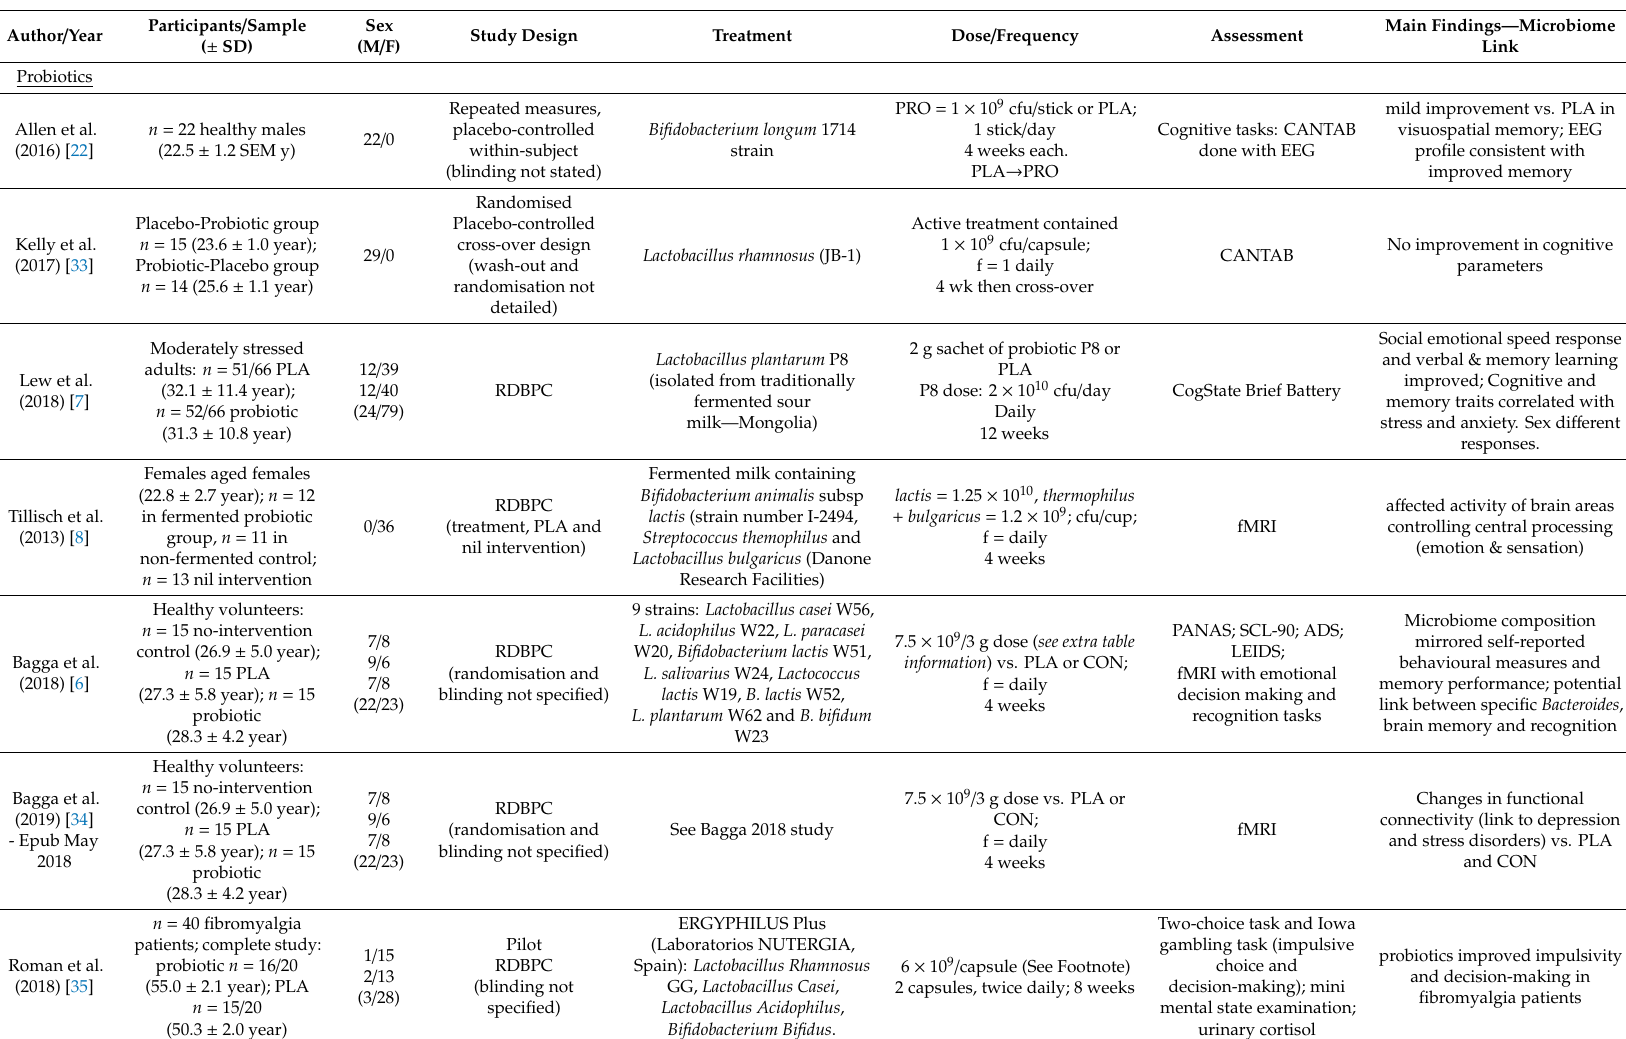
Table 3. Human studies describing interventions on the gut microbiota and the e ff ects on cognition, brain structures and